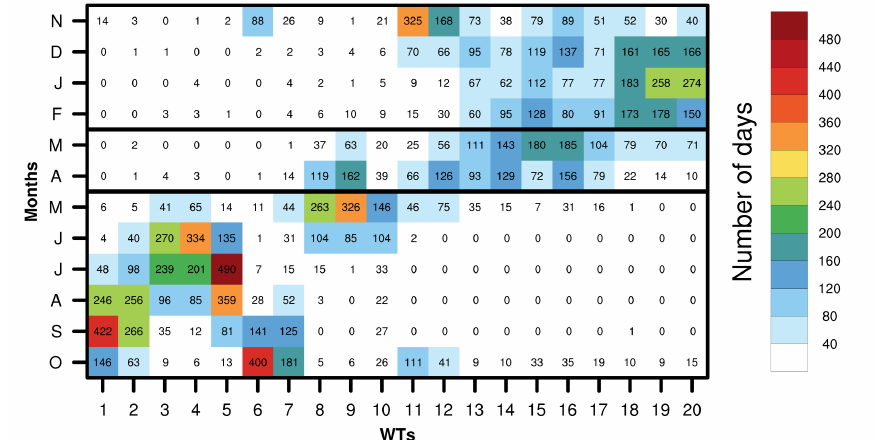
Figure 3. Monthly frequency of occurrence (in days) for each weather type. Horizontal thick lines divide the annual march (see Section 2.2) into 3 periods: a dry-cold period (November–February); a dry-warm period (March–April); and a wet period